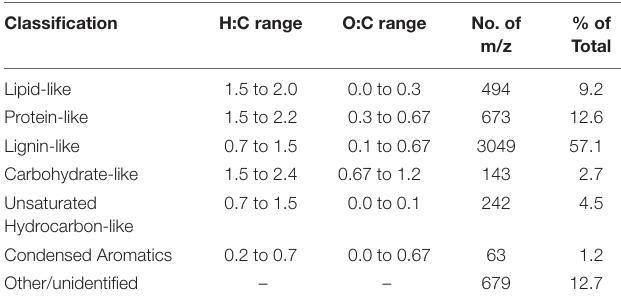
TABLE 1 | Elemental ratios and compound classification characteristics of masses detected in extracted tDOM source using FT-ICR